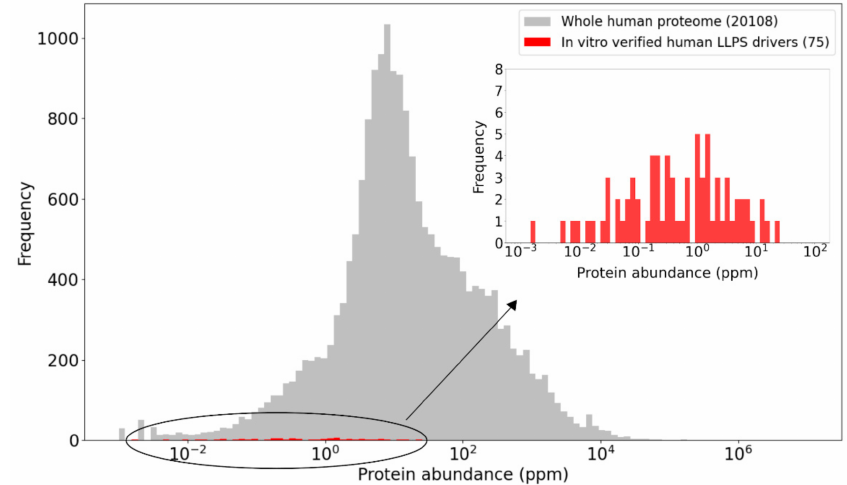
Figure 4. Human LLPS driver proteins are of relatively low abundance compared to the proteome average. The highest tissue- or cell type-specific integrated abundance value was derived for each human protein from PaxDb. These maximal abundances of human LLPS driver proteins (red) are compared to those of the proteome (grey) using histograms. The abundances of LLPS drivers are also separately depicted in the inset histogram to ensure better resolution of the data. Abundances are provided in parts per million (ppm) units on the